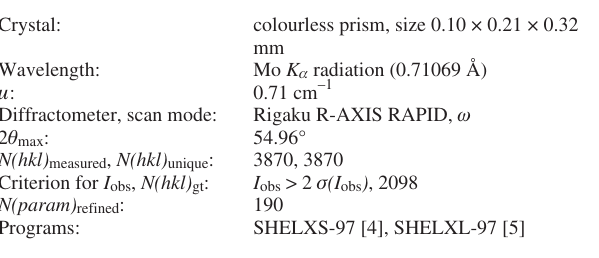
Table 1. Data collection and handling.